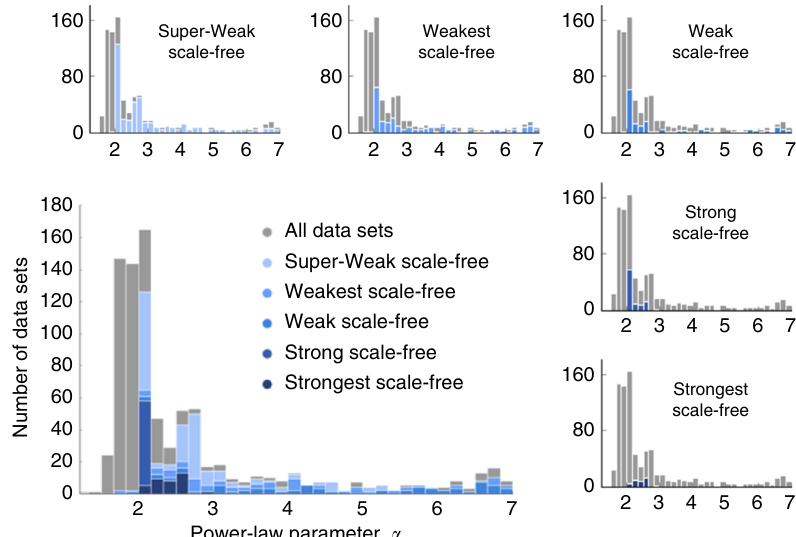
Fig. 3 Distribution of ^ α by scale-free evidence category. For networks with more than one degree sequence, the median estimate is used, and for visual clarity the 8% of networks with a median ^ α (cid:2) 7 are